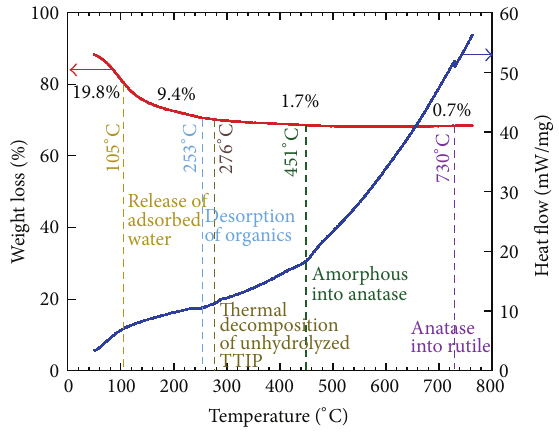
Figure 1: TG-DTA curve of N-TiO 2 samples prepared with 2.0 ammonia/TTIP